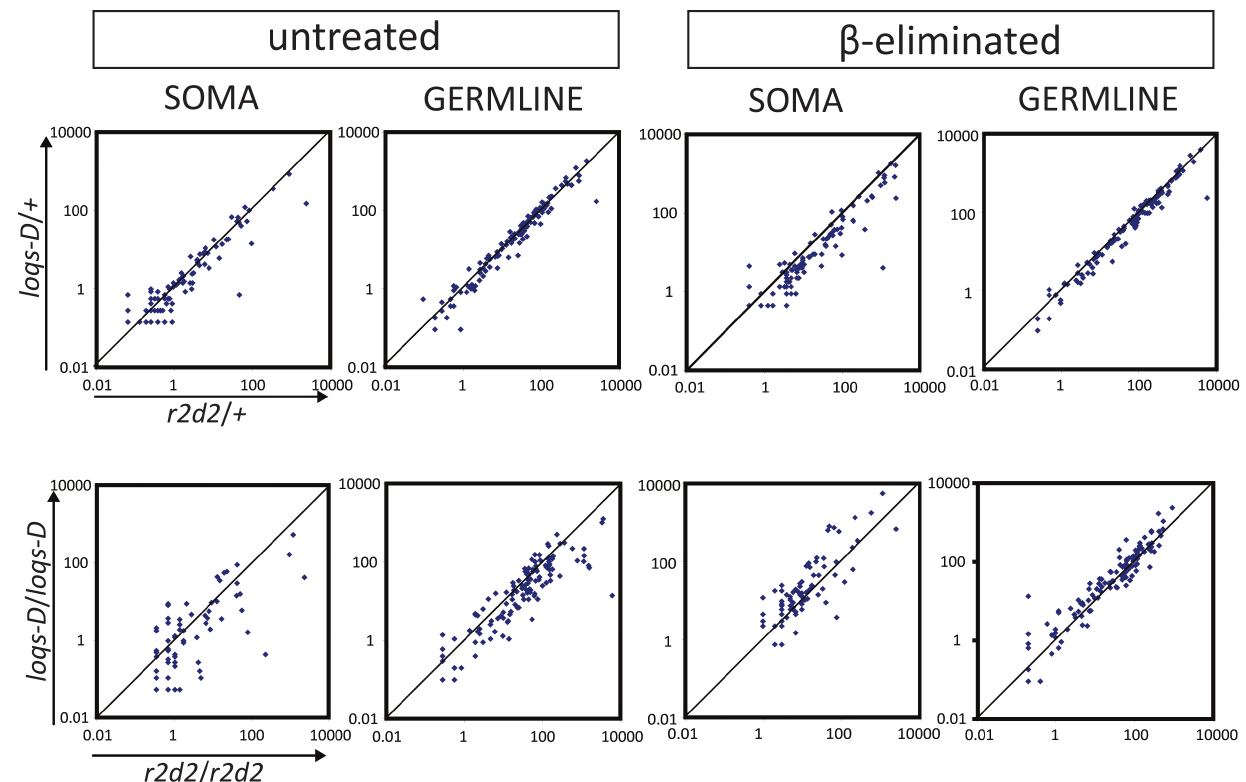
Figure 3. Changes in processing and loading of small RNAs matching to individual transposons in r2d2 and loqs-D mutants. Transposon mapping endo-siRNA were normalized to total genome matching reads and expressed as reads per million (RPM). Each dot in the plot represents an individual transposon consensus sequence. The upper two panels compare of heterozygous r2d2 and loqs-D mutants during processing (left) and loading (right) for soma and germline. The lower panels compare homozygous r2d2 with homozygous loqs-D mutants. For example, a higher amount of endo-siRNAs in r2d2 homozygous mutant than in loqs-D homozygous mutants means that these endo-siRNAs are r2d2 independent but loqs-D dependent. They are thus situated below the diagonal, whereas transposons that require loqs-D but not r2d2 will fall above the diagonal.